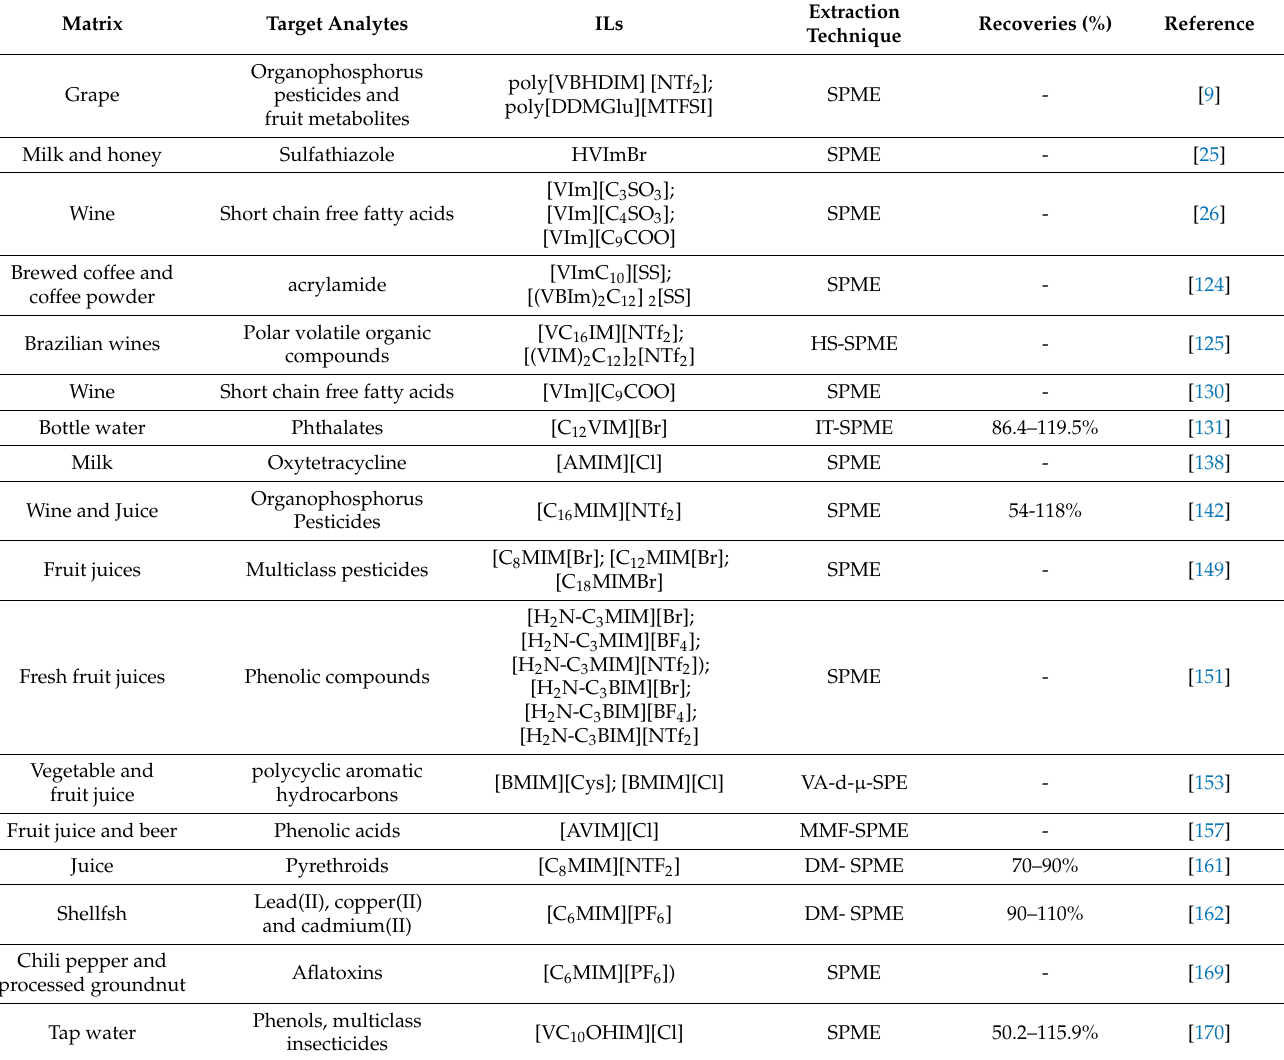
Table 2. Representative application examples of IL-based SPME in food samples